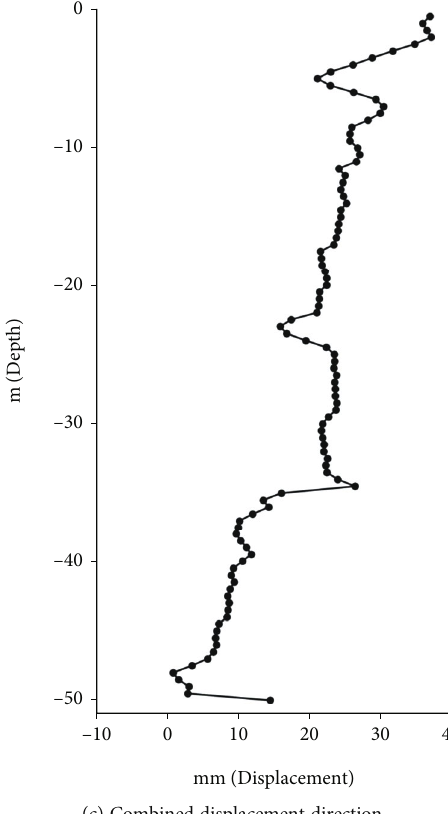
Figure 5: Accumulative displacement-depth curve in N-S and W-E directions and accumulative resultant displacement-depth curve of ZK4-1 borehole (October 18,